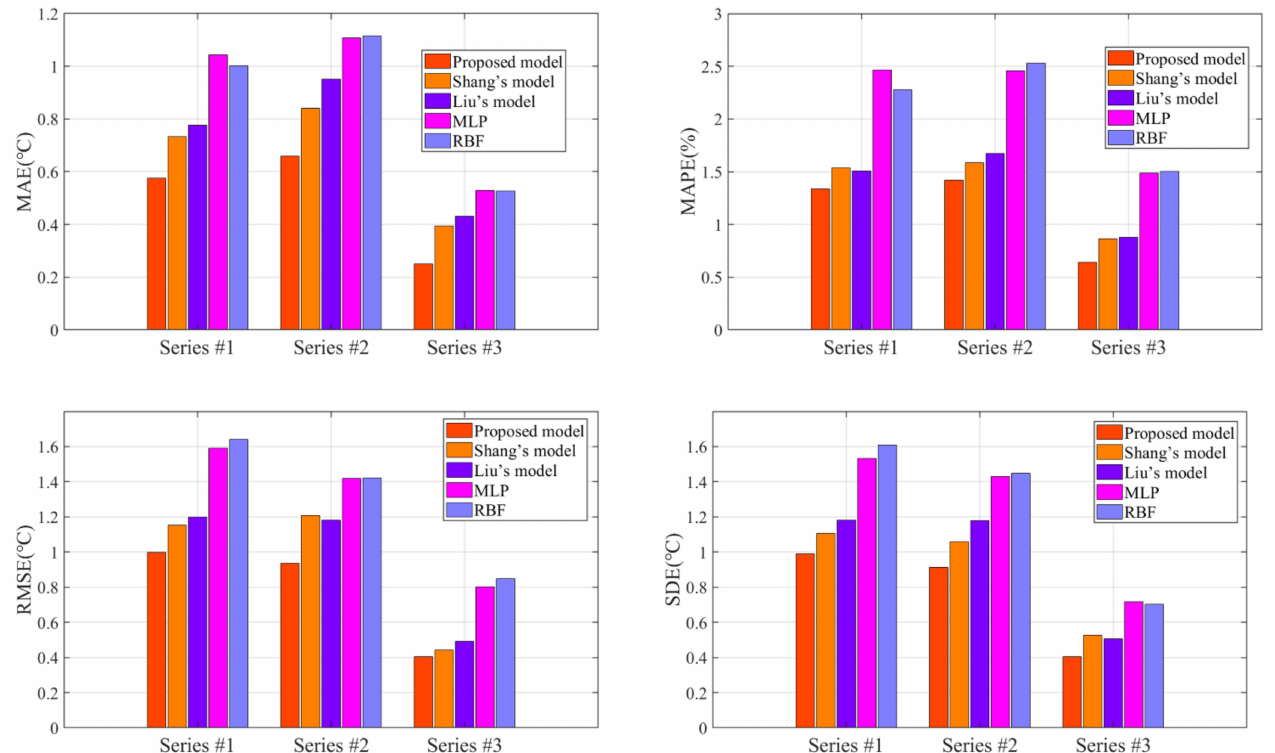
Figure 12. Forecasting performance evaluation indexes: MAE, MAPE, RMSE, and SDE values of the proposed model and existing